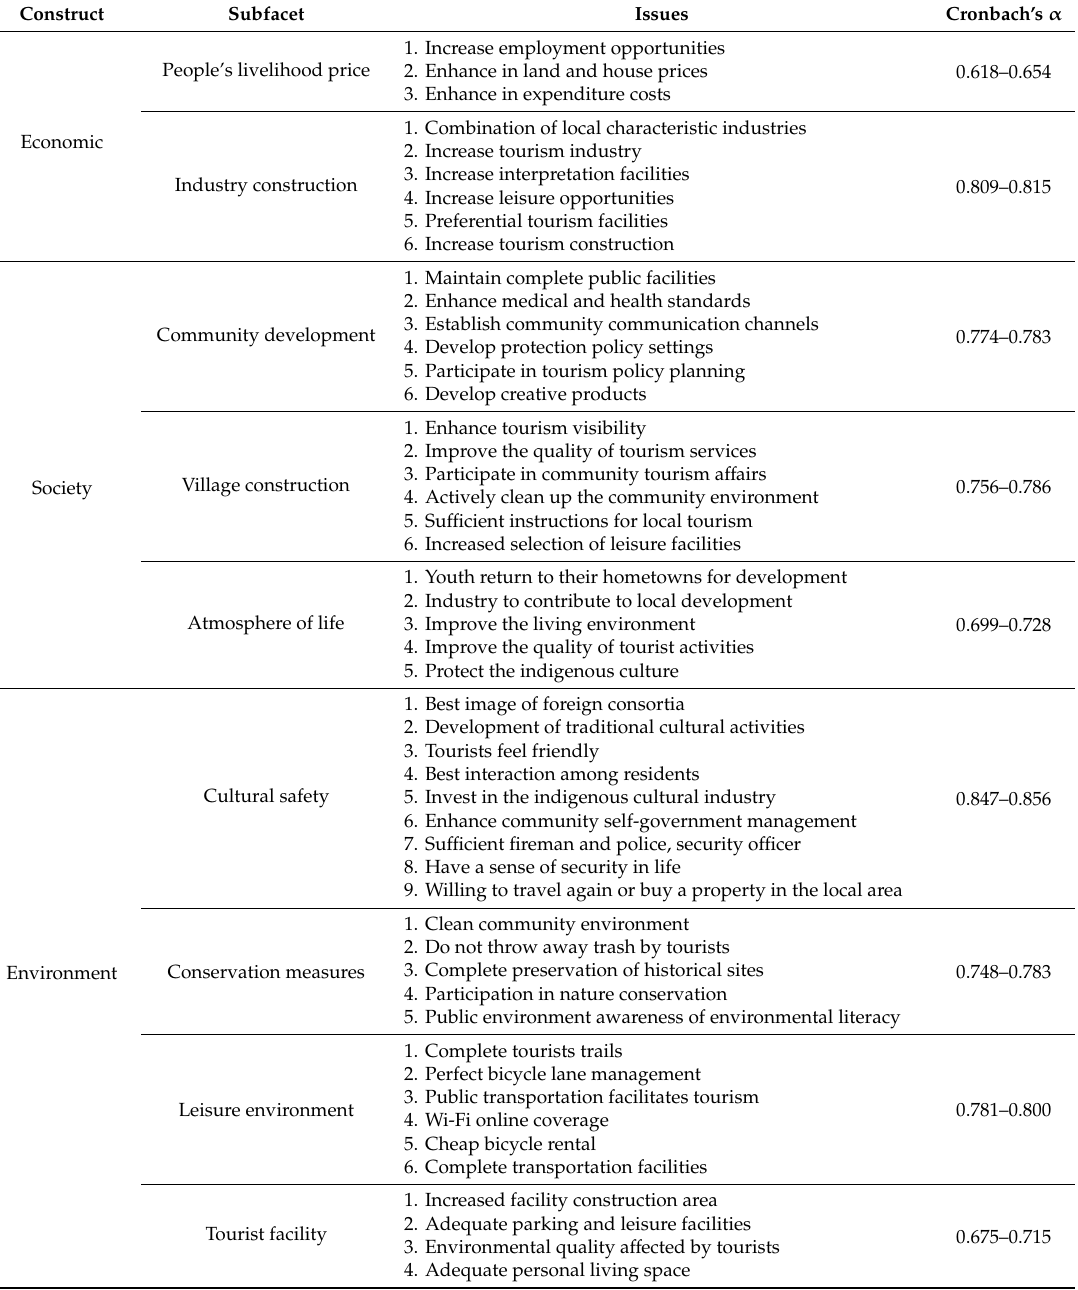
Table 2. Analysis of the Tingxi Reservoir Tourism Development Perception